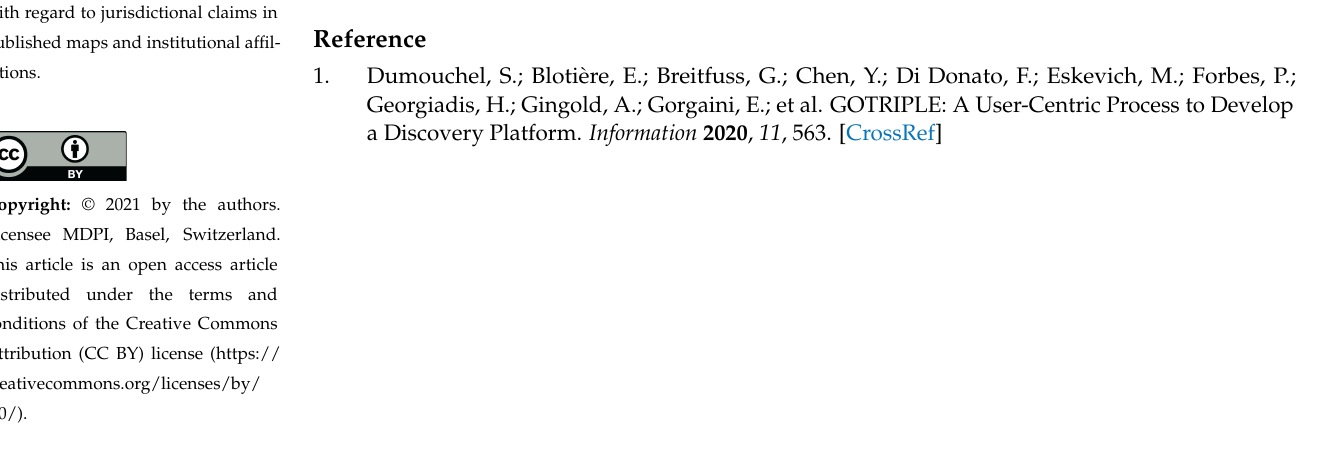
“Figure 12. Schematic and simplified representation of the two-fold approach to ingest Figure 13. A generic processing chain (© 2020 St é phane